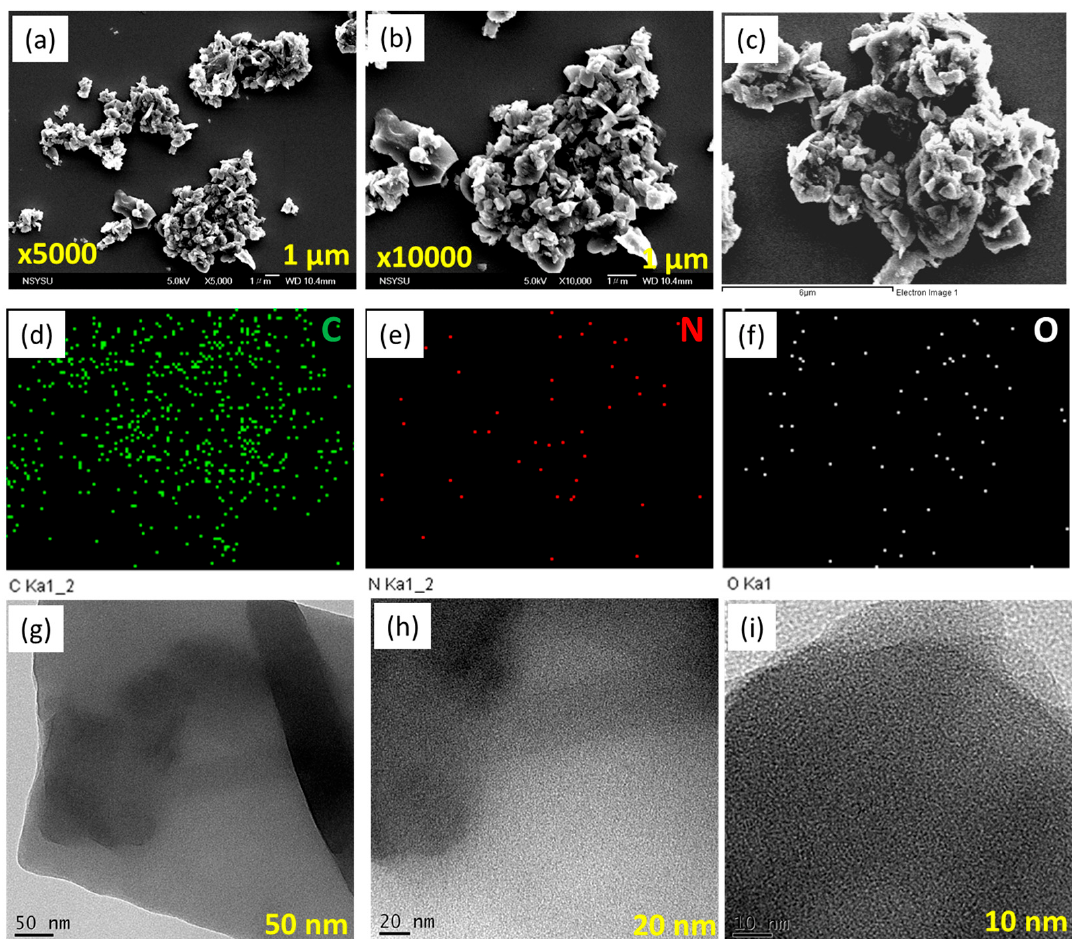
Figure 5. SEM ( a , b ), EDS-SEM ( c–f ), and TEM ( g – i ) images of Py-PDT POP-600.